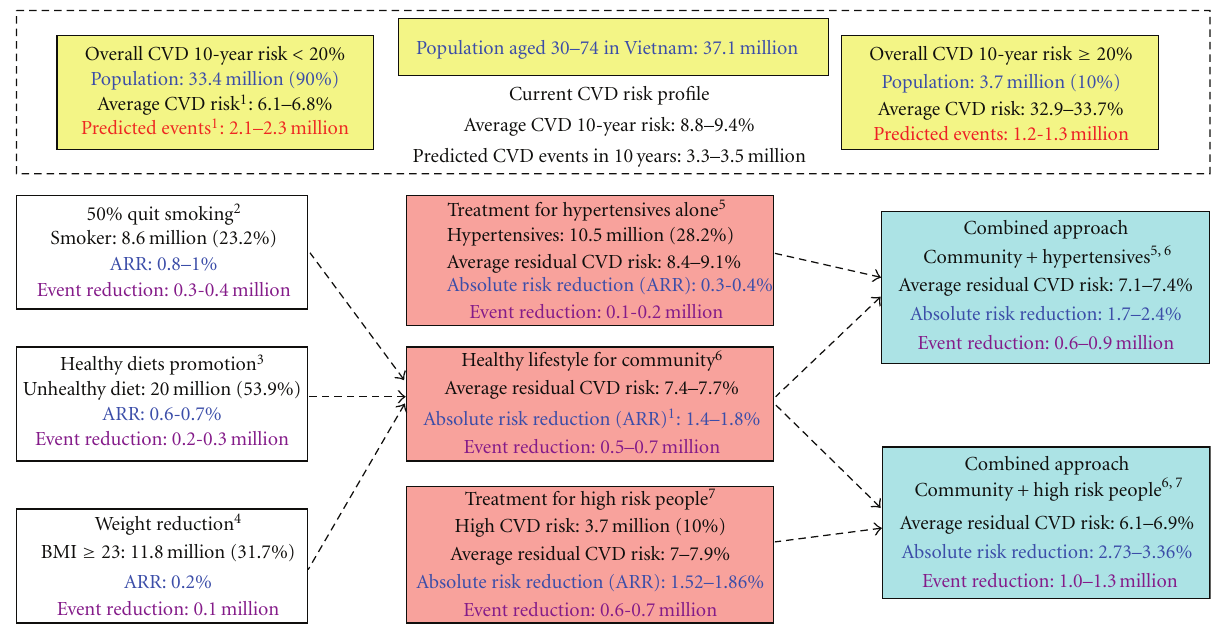
Figure 3: Estimation of cardiovascular burden and potential benefits of intervention strategies for the adult population of Vietnam, extrapolated from the average of individual overall CVD 10-year risks in a studied population. 1 Overall cardiovascular (CVD) risk, residual risk, absolute risk reduction (ARR), and predicted CVD events or predicted event reduction were estimated by both versions of Framingham general risk score, one used lipid profile and the other used BMI, and weighted by national age structure of the Vietnamese population in 2009. 2 In assumption that the prevalence of current smoking will reduce by 50%. 3 In assumption that the e ff ect of healthy diet (especially salt reduction) will reduce 5mmHg of systolic blood pressure (SBP). 4 In assumption that the obesity (BMI ≥ 23) will reduce 10% of weight, the risk was only estimated by BMI version of Framingham general risk score. 5 Approach for hypertensive alone included drug therapy to control BP (targeted SPB ≤ 140 for any hypertensives and ≤ 130 for diabetes). 6 Approach for community included healthy lifestyle promotion campaigns: quitting smoking (in assumption of 50% reduction of current prevalence), healthy diet (salt reducuon, low-fat and high-fiber diet, in assumption of 5mmHg reduction of SBP), and encouraging physical activity and 10% weight reduction for obesity (BMI ≥ 23). 7 Approach for high-risk people (overall CVD 10-year risk ≥ 20%) included quitting smoking (100%), drug therapy to control BP (targeted SBP ≤ 140 for any hypertensives and ≤ 130 for diabetes), statin for dyslipidaemia (in assumption of 20% reduction of total cholesterol, 10% increase HLD-C), and 10% weight reduction for obesity (BMI ≥